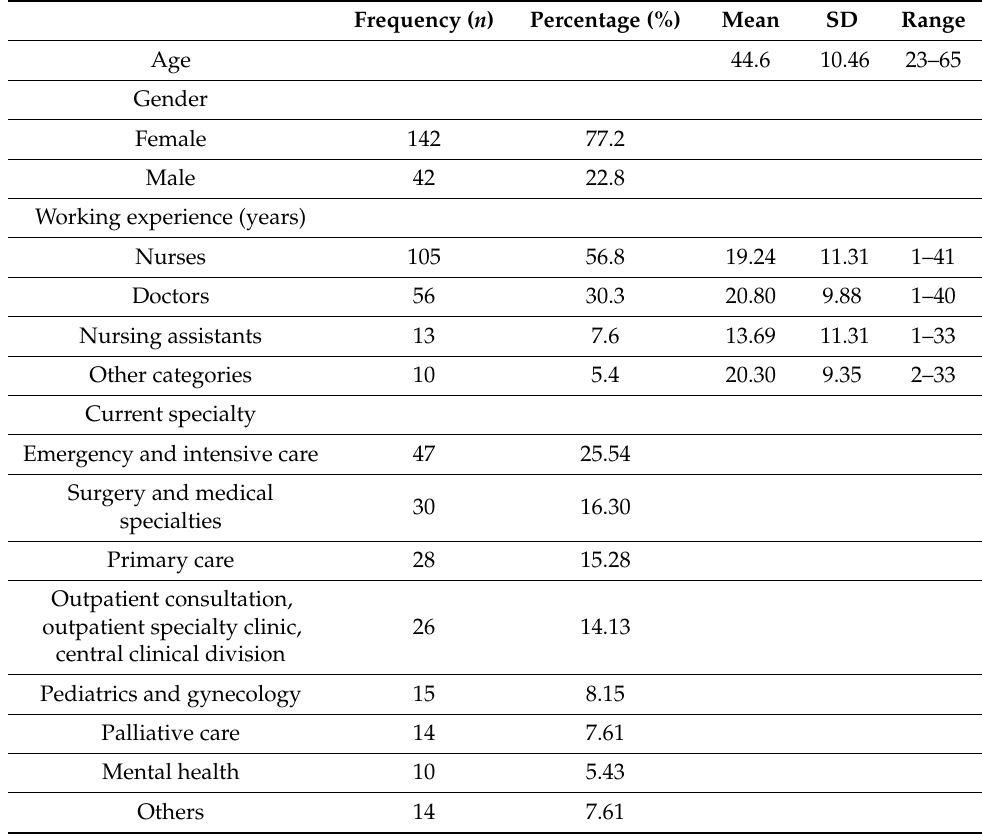
Table 1. Demographics of study